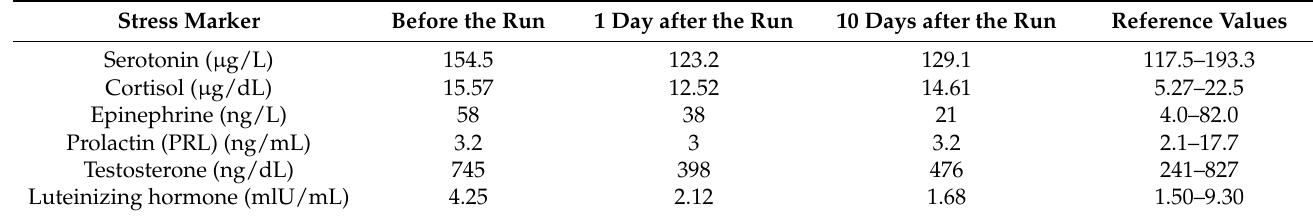
Table 4. Summary results of physical and mental stress markers.